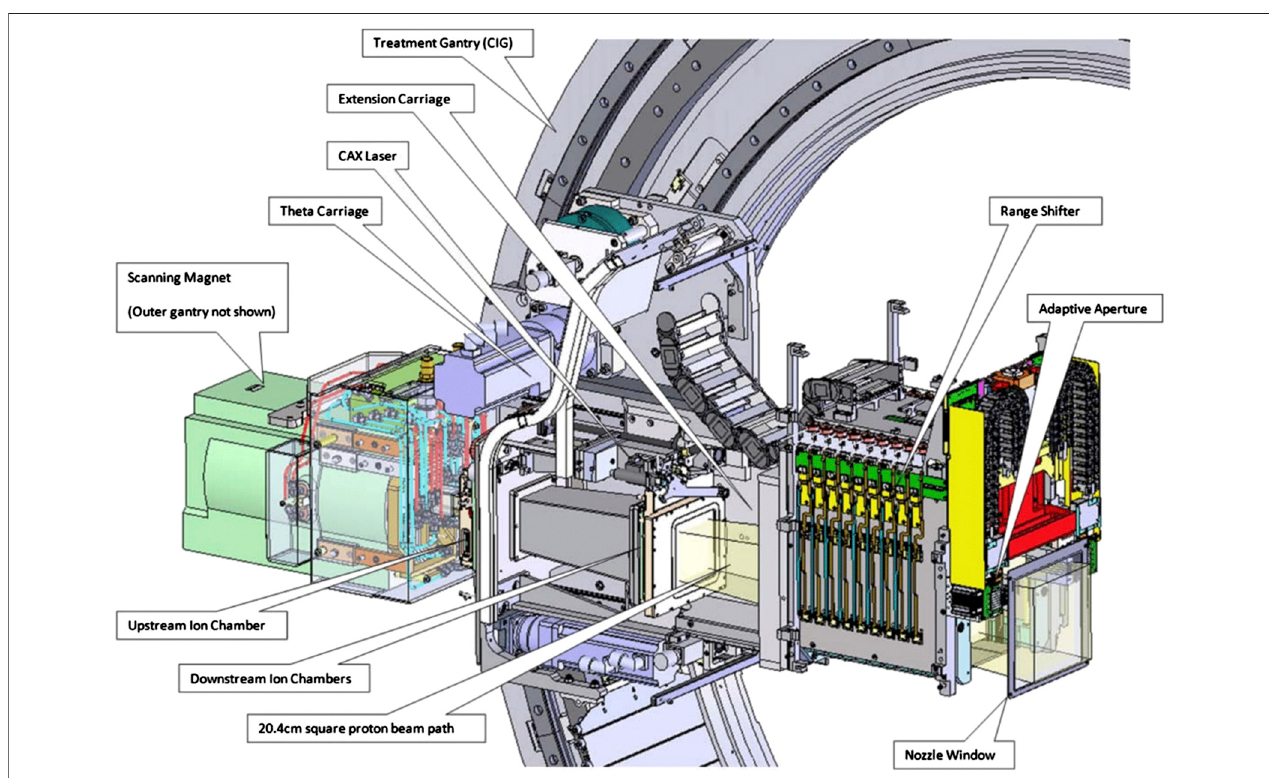
FIGURE 1 | Layout of the Mevion S250i. Courtesy of Mevion.